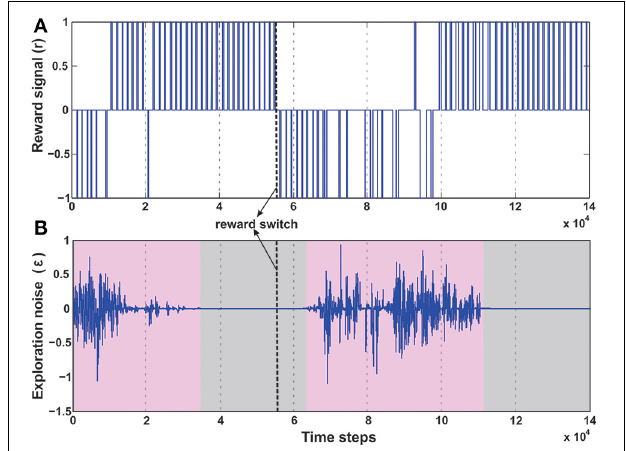
FIGURE 10 | Temporal development of the reward and exploration noise for the dynamic foraging task. (A) Change in the reward signal (r) over time. Between 3 × 10 4 time steps and 5 × 10 4 time steps the robot learns the initial task of reaching the green goal, receiving positive rewards ( + 1), successively. However, after 50 trials (approximately 5 × 10 4 to 5 . 5 × 10 4 time steps) the reward signals were changed, causing the robot to receive negative rewards ( − 1) as it drives to the green goal. After around 10 × 10 4 time steps as the robot learns to steer correctly toward the new desired location (blue goal), it successively receives positive rewards. (B) Change in the exploration noise ( (cid:12) ) over time. There is random exploration in the beginning of the task and after switching the reward signals (pink shaded regions), followed by stabilization and decrease in exploratory noise once the robot learns the correct behavior (gray shaded region). In both plots the thick dashed line (black) marks the point of reward